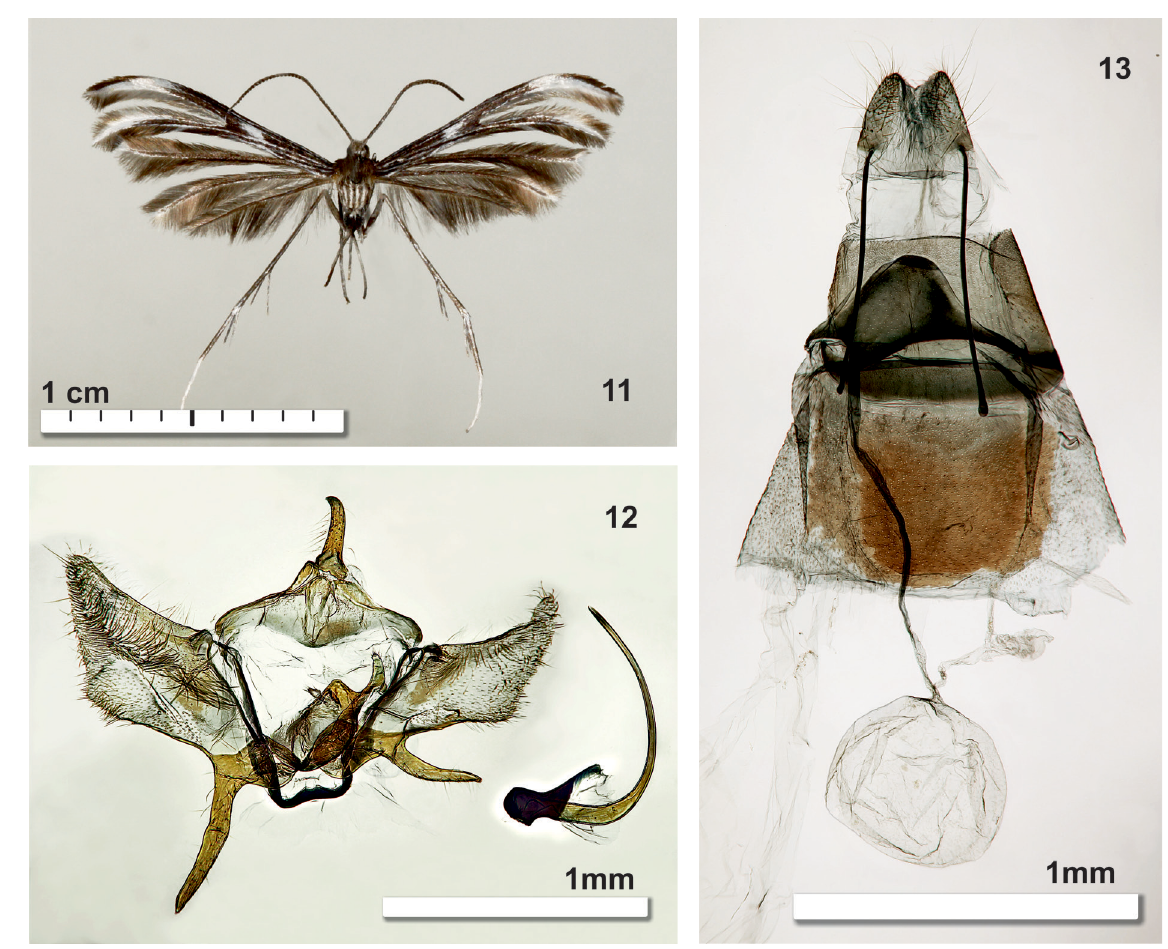
Figs 11–13. Singularia lesya Kovtunovich & Ustjuzhanin sp. nov. 11 . Holotype (ZISP 1840). 12 . Holotype, genitalia (ZISP 1840). 13 . Paratype, ♀, genitalia (ZISP